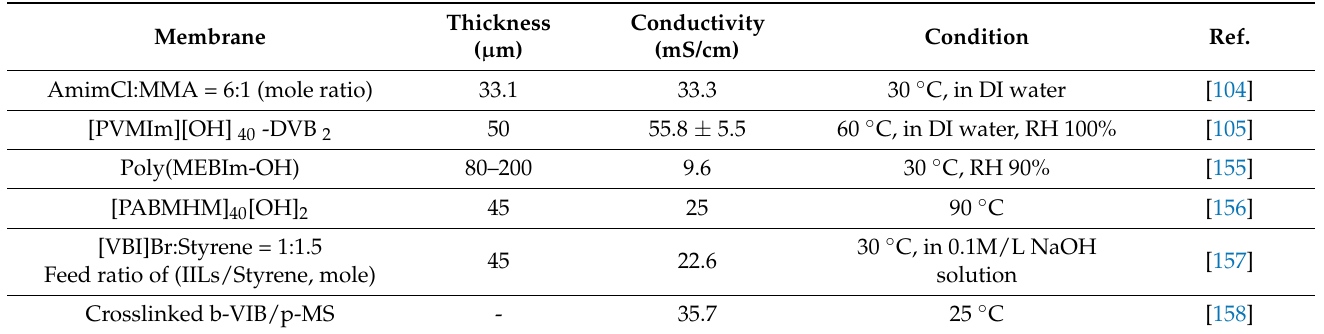
Table 8. Ionic conductivity of ILs-based